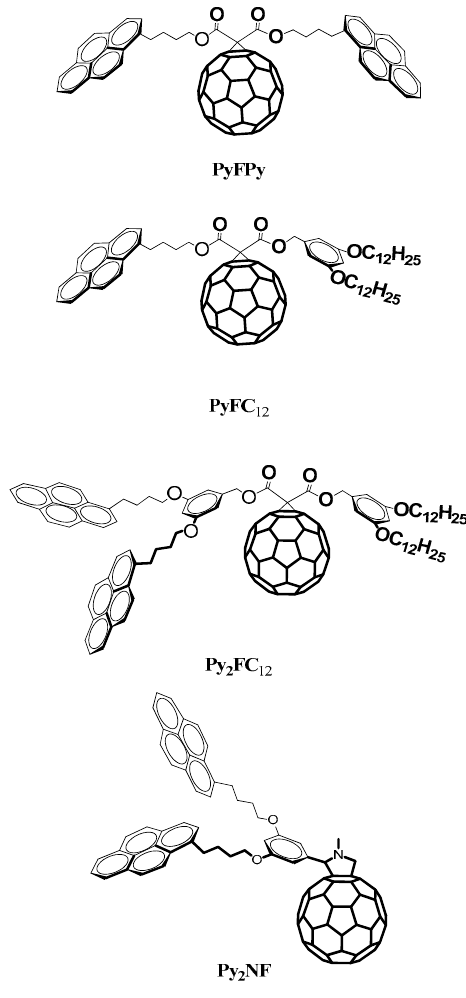
Figure 7. Structures of the novel compounds bearing pyrene and Fullerene C 60 [48].